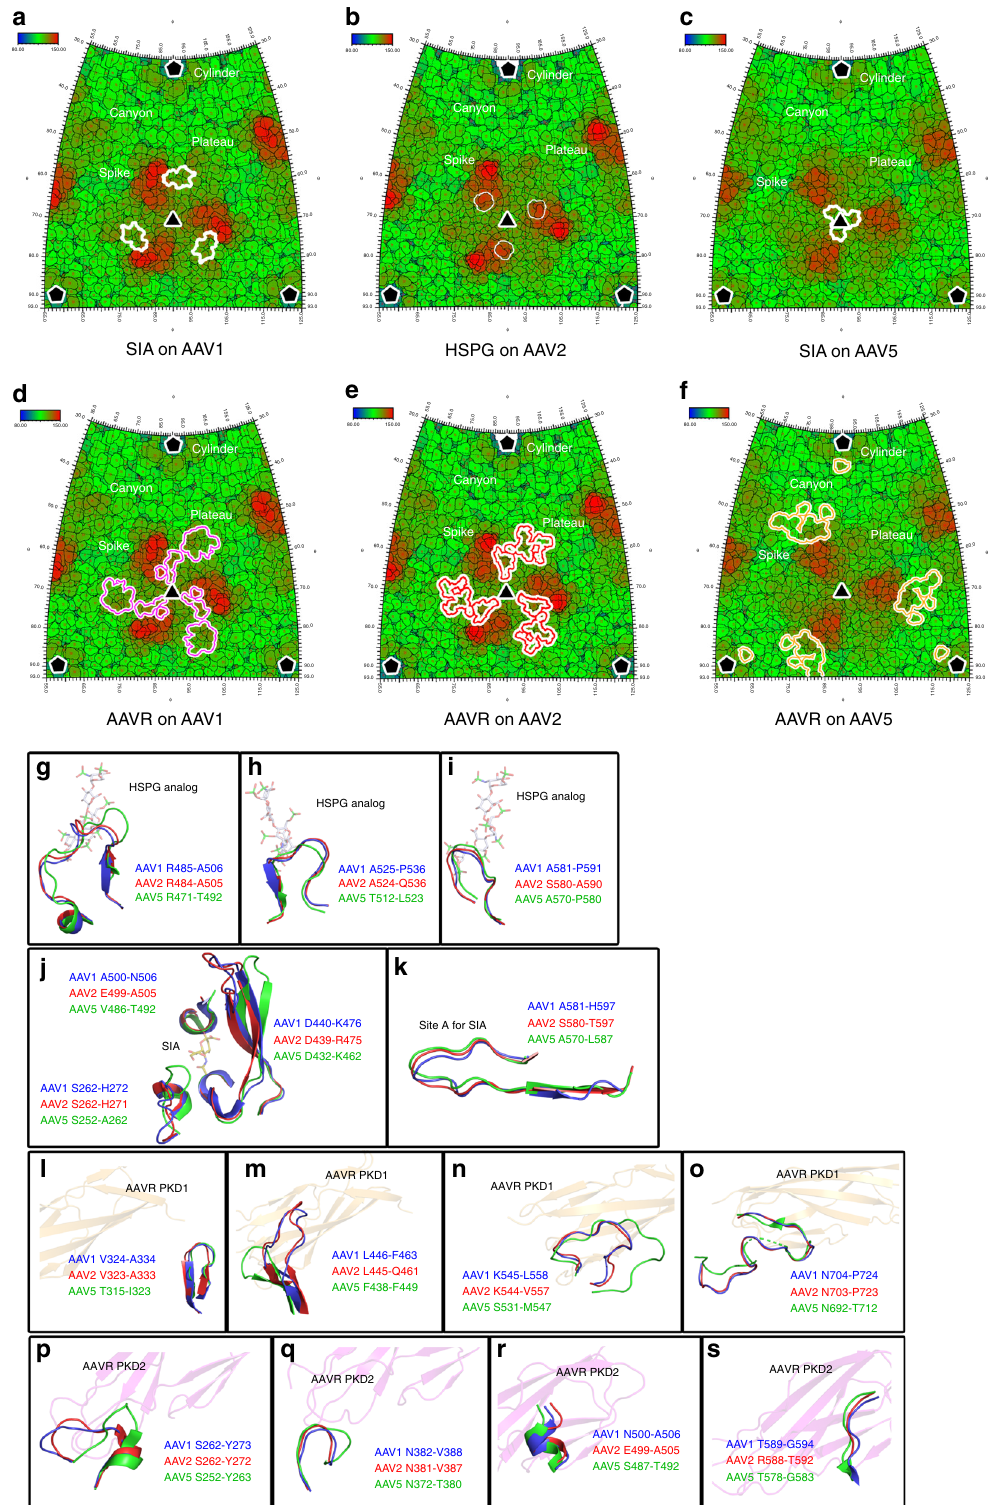
AAV1 have large conformational discrepancy (Fig. 4j). Particularly, shadowing the SIA binding pocket. There are two SIA-binding sites found on the AAV5 capsid, but only site A play essential role for AAV5 transduction 13 . Notably, the structures of site A on the AAV5 capsid and the corresponding regions on the AAV1 and AAV2 capsids display high similarities (Fig. 4k).